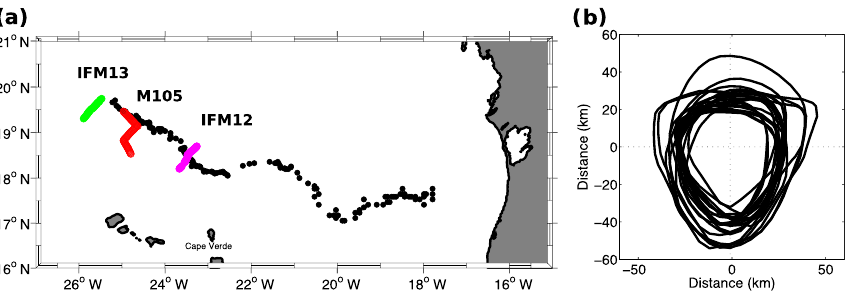
Figure 1. (a) Positions of the glider IFM12 (magenta) and IFM13 (green) surveys and the M105 ship survey (red dots). The Mauritanian coast is in the east, the Cape Verde Islands in the south. The black dots represent the sea level anomaly (SLA) based estimate of the eddy trajectory (see e.g. Fiedler et al., 2016). (b) Last closed geostrophic contours from SLA analysis during the IMF12 survey projected on the eddy